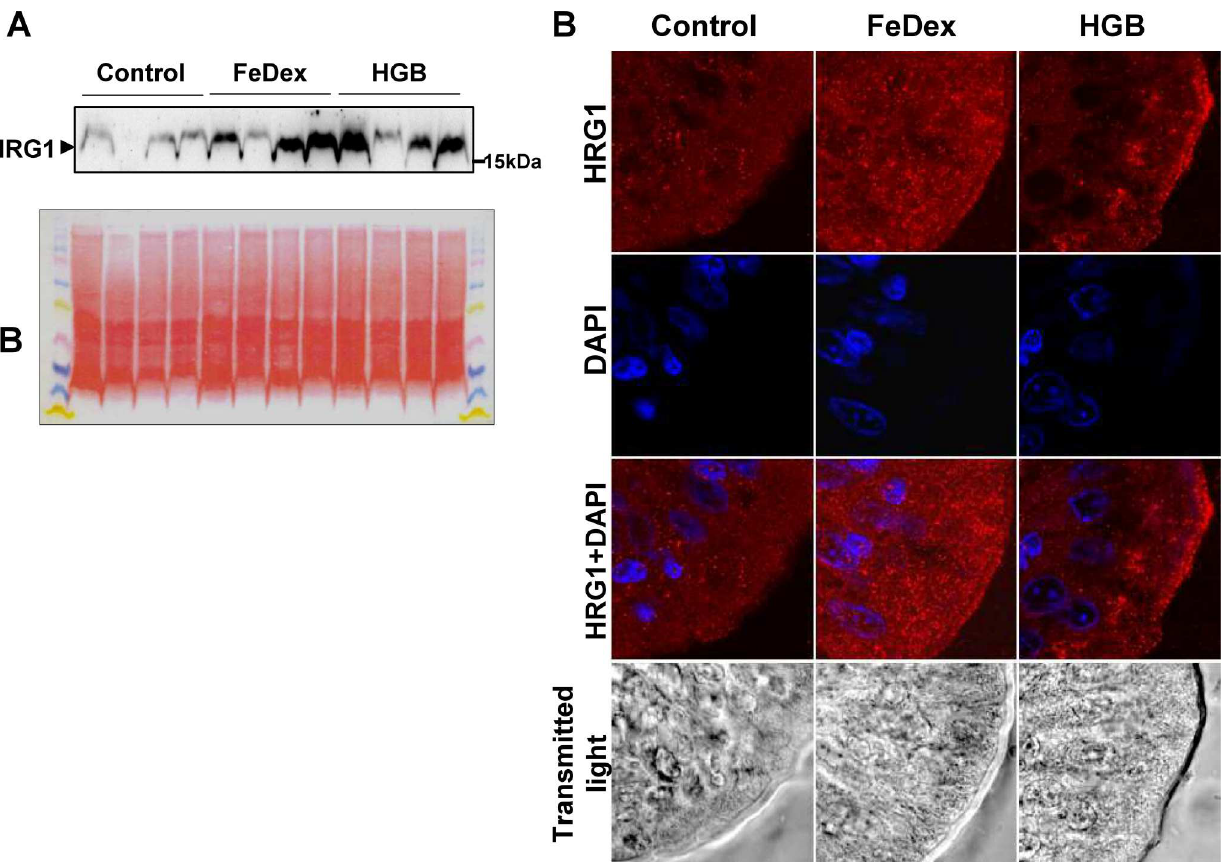
Fig 3. IncreasedHRG1 protein levels on the apical membrane of absorptive enterocytes of piglets fed a hemoglobin-enriched diet. (A) Western blot analysisof HRG1 protein levels in membranefractions preparedfrom duodenal scrapingsas describedunder Materials and methods. A representative immunoblot is shown. PonceauRed stainingof transferred proteins are shown (bottom panel)to confirm equivalent loading. (B) Immunofluorescent staining of HRG1 in the duodenum.To confirm the specificity of HRG1 detection, duodenumsectionsof piglets were incubatedwith only the secondaryantibody.No HRG1 stainingwas detected in these negativecontrols. Counterstaining of nuclei was performed with DAPI. Duodenummorphology is shown in transmitted light.